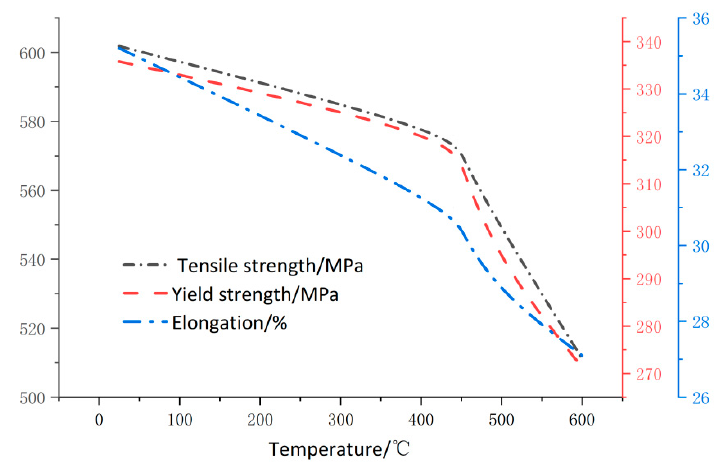
Figure 12. Characteristic strength is correlated. Table 3. Physical parameters of 20G steel after heat treatment at 450 °C.